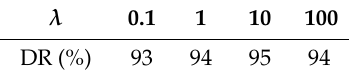
Table 5. Detection results using different values of λ .